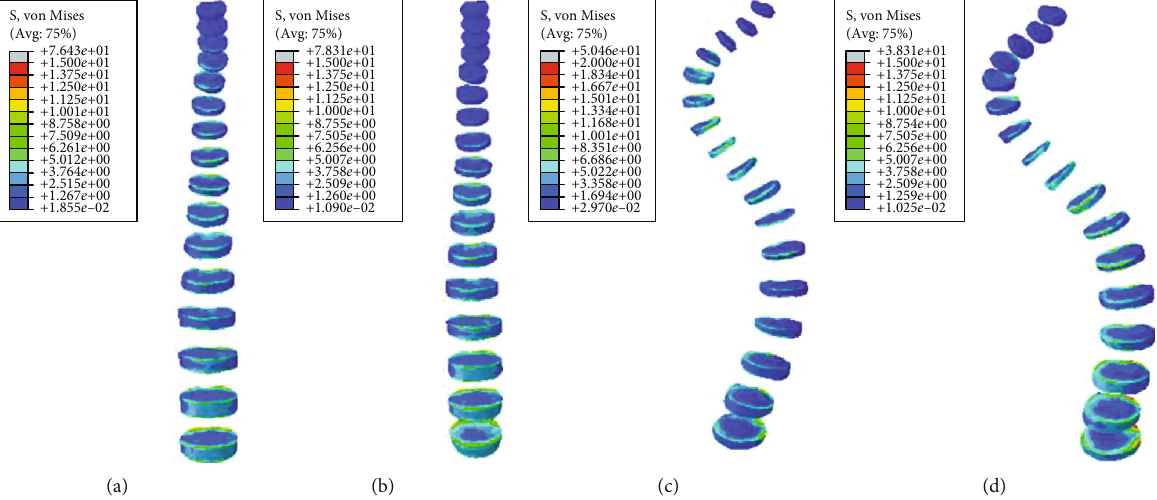
Figure 10: von Mises stress distribution of disc in four spinal models with posterior supine: (a) normal spine without rib cage (NS1); (b) normal spine with normal rib cage (NS2); (c) scoliotic spine without rib cage (SS1); (d) scoliotic spine with deformed rib cage